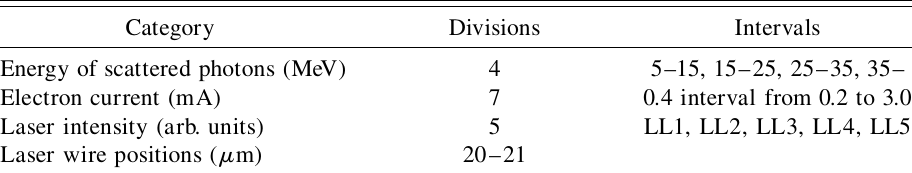
TABLE I. Classification of the scaler counts. Category